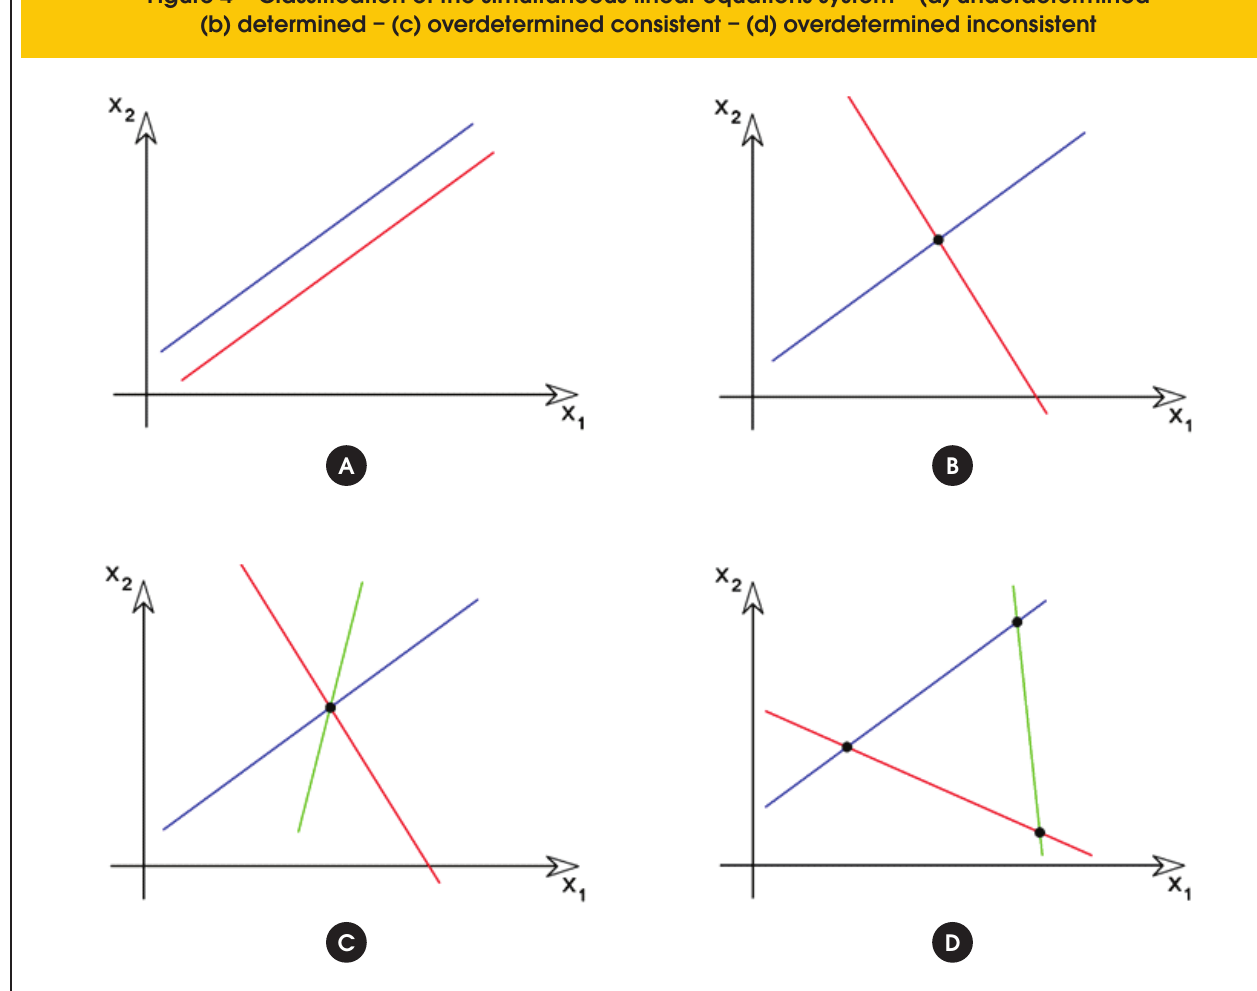
Figure 4 – Classification of the simultaneous linear equations system – (a) underdetermined (b) determined – (c) overdetermined consistent – (d) overdetermined